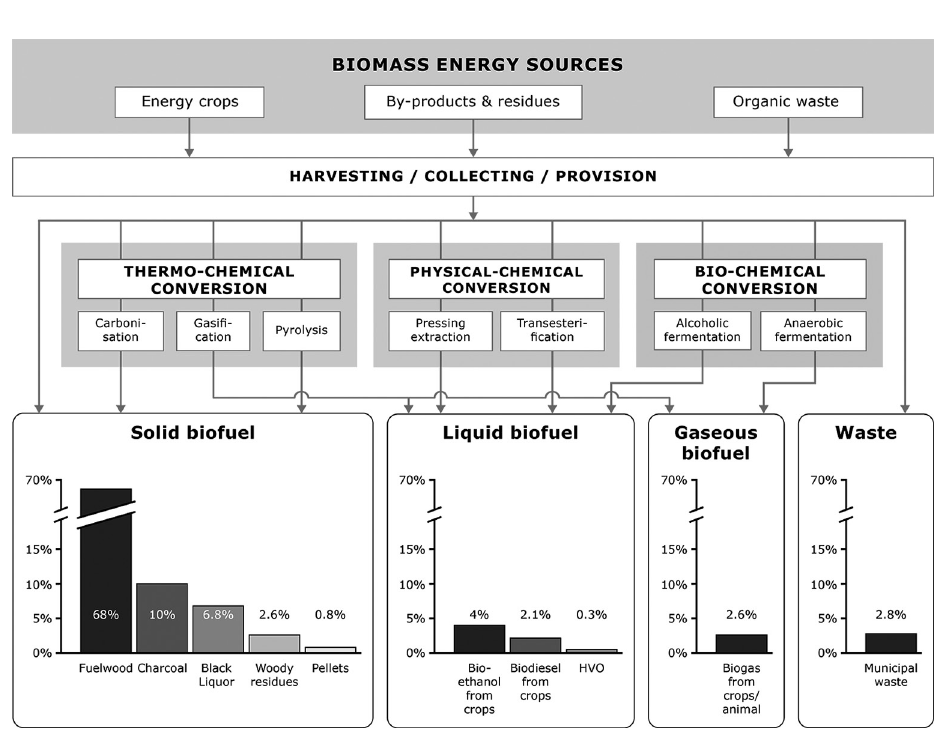
Fig. 2. – Bioenergy carriers